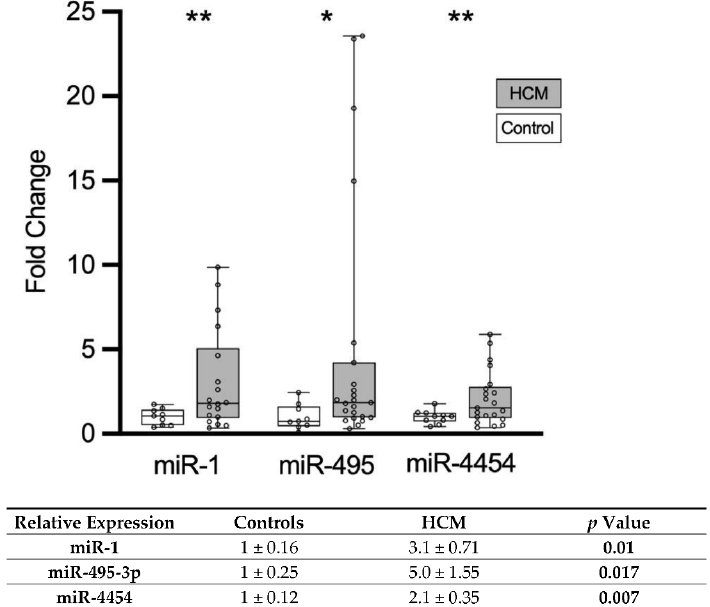
Figure 1. RT-qPCR validation of putative circulating miRNA biomarkers for HCM. Quantification was carried out using the ∆∆ -Ct method. Whisker-plot showing relative expression with median, IQR, minimum and maximum. In the table, the mean of relative expression ± standard error of the mean (SEM) of circulating miRNAs is shown. Three miRNAs could be validated and were upregulated in patients with HCM (white columns) compared to healthy controls (black columns). A p -value of <0.05 was considered statistically significant and marked in bold. Data are expressed as mean ± SEM, with * p < 0.05 and ** p < 0.01 vs. healthy controls, unpaired Welch’s